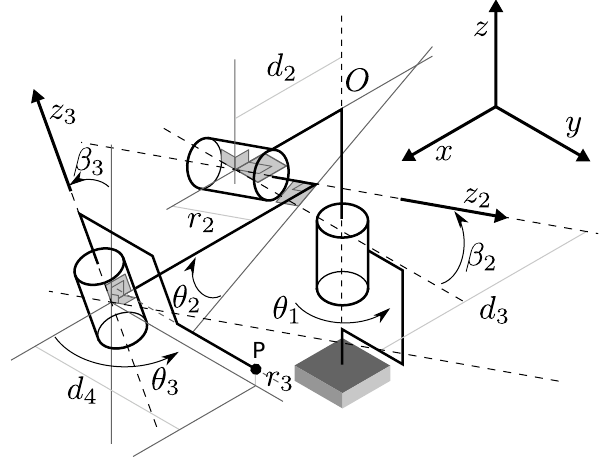
Figure 1. Kinematic diagram of a general 3R manipulator with θ 1 = 0.